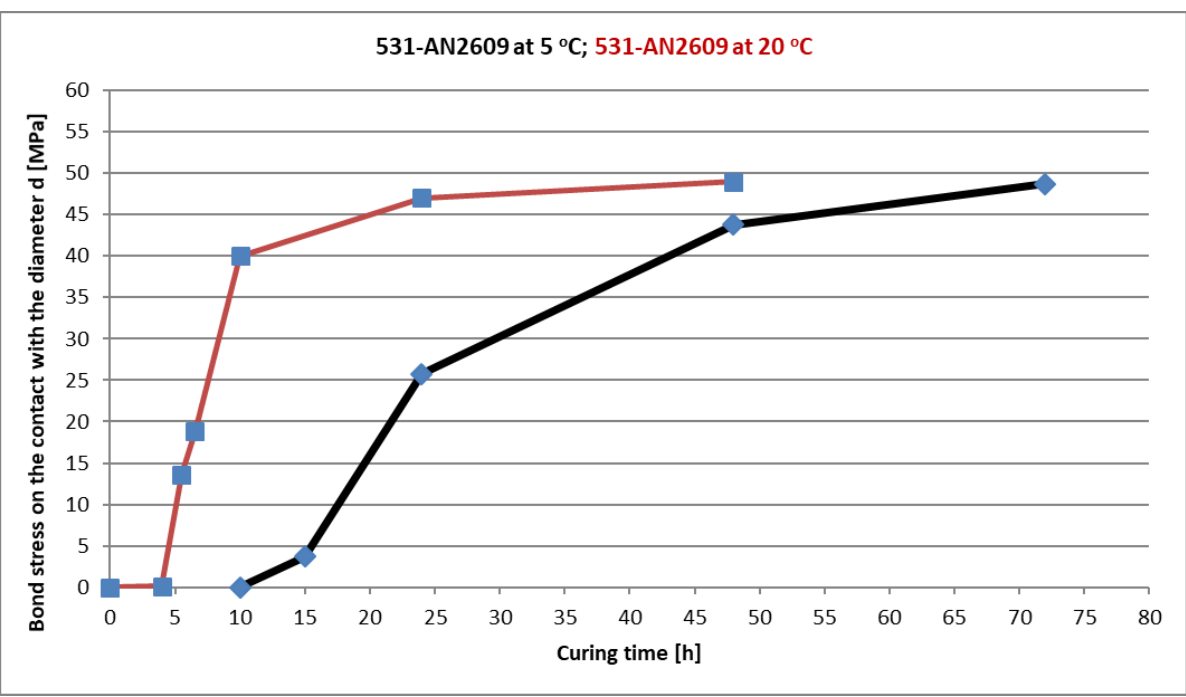
Figure 17. CHS Epoxy 531 with AN2609 curing accelerator. Bond strength is dependent on the curing time at a temperature of 5 °C and room temperature of 20 °C.